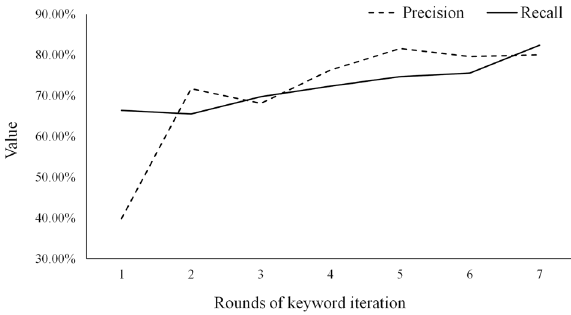
Fig. 5 Model accuracy evaluation. The broken line represents Precision and the solid line indicates Recall, and the fi gure shows the trend of both with the increase of keyword iteration rounds.